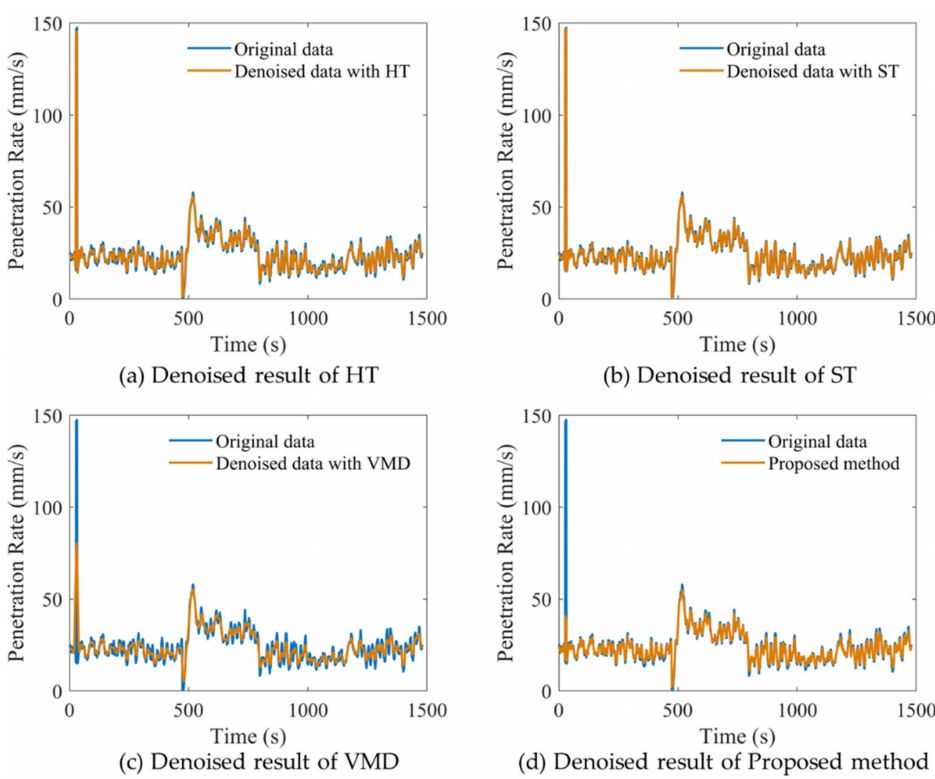
Figure 6. Comparisons between real and denoised data for dataset 1.